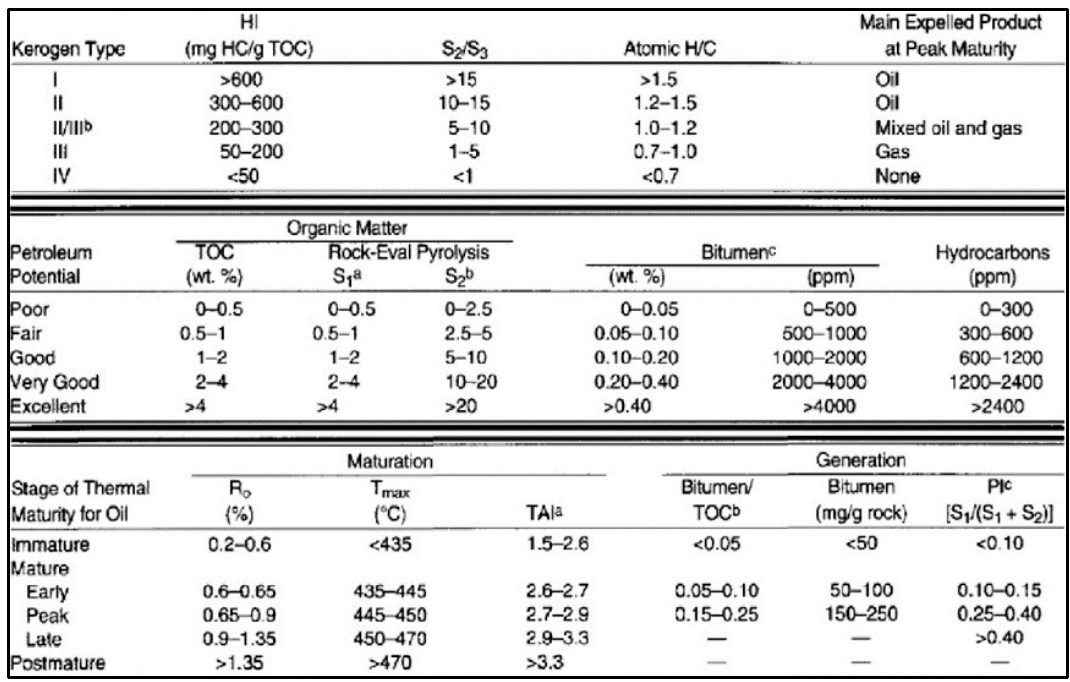
Figure 8. Categorization of organic matter in terms of quantity, quality, and thermal maturity [6].